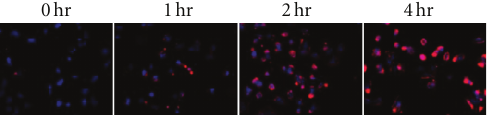
Figure 5: α -ALCAM-conjugated PLNs show cell-specific targeting in a time-dependent manner. α -ALCAM-conjugated PLNs were incubated with osteosarcoma cells for 0, 1, 2, and 4 hours then washed o ff . α -ALCAM targeted PLNs bind specifically to the ALCAM expressing osteosarcoma cell line KHOS240s at one hour and reach a maximum binding at 4 hours of incubation. Flu- orescence microscopy of PLNs (shown in red) with DAPI (blue) nuclear counterstaining (magnification 20x).